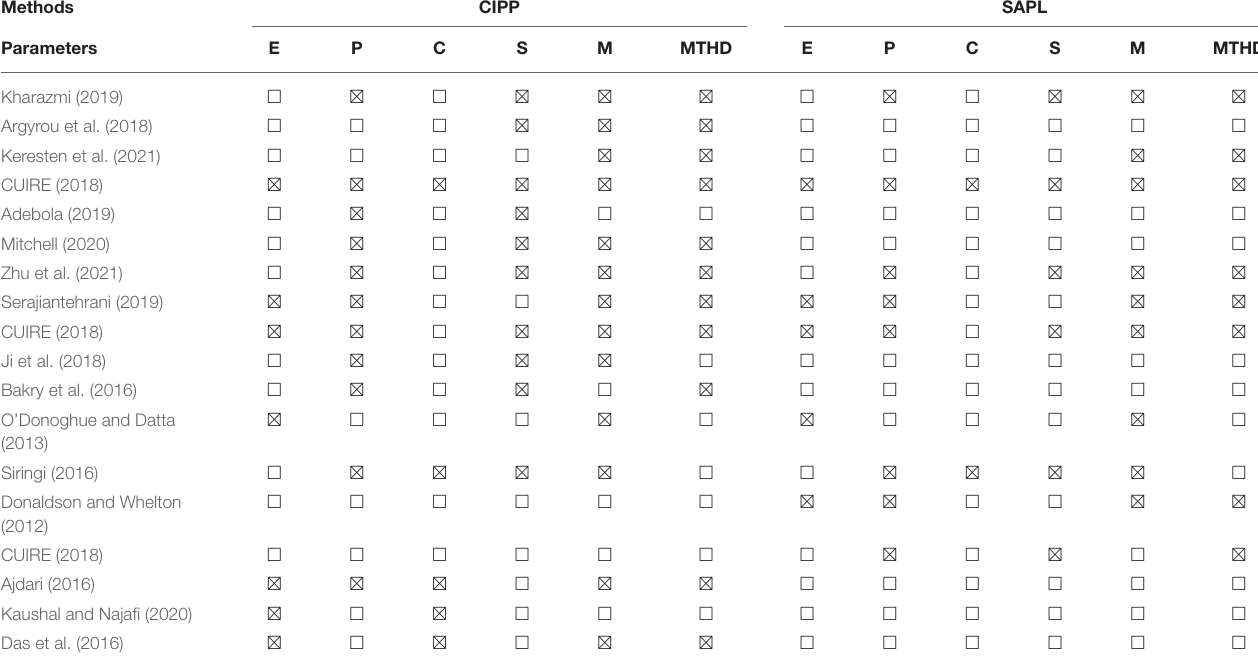
TABLE 2 | Comparative review table. Methods CIPP